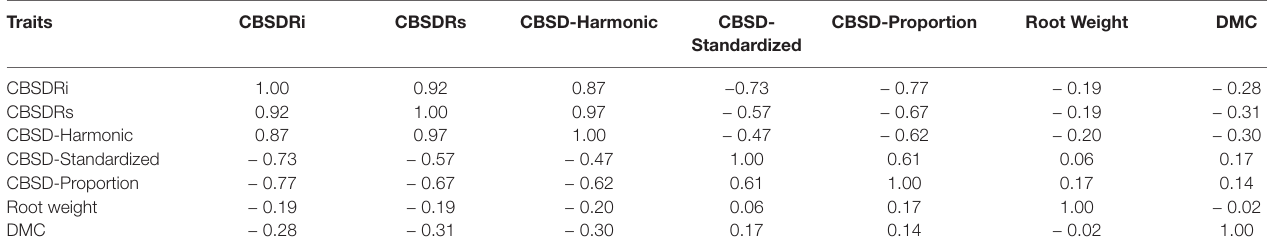
TABle 2 | Correlation among CBSD root necrosis traits. Traits CBSDRi